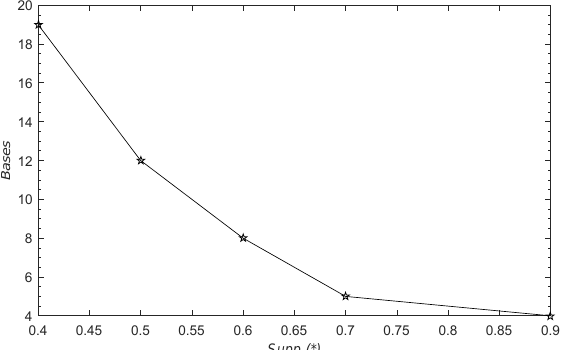
Figure A1. Change of bases in the mushroom database corresponding to supp r (